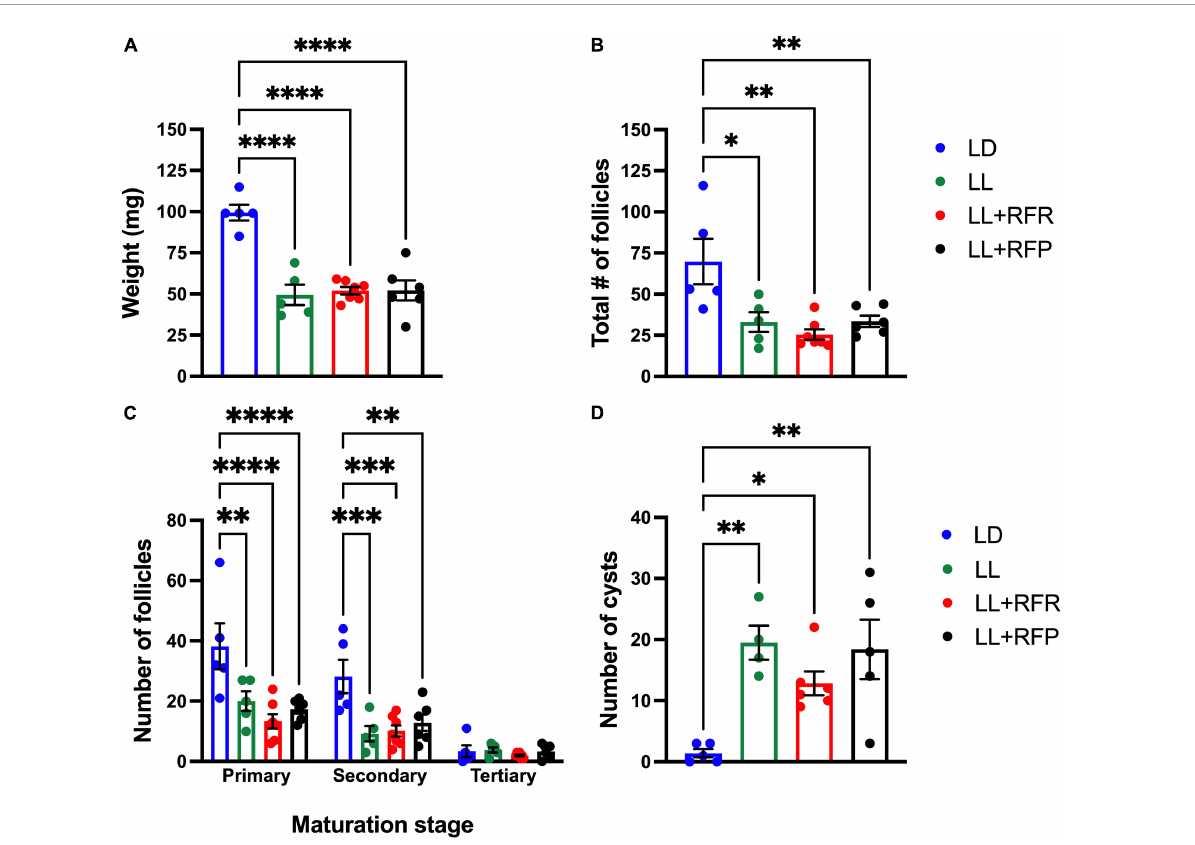
FIGURE4 Ovary weight and morphology after LL exposure and the 12-h feeding schedules. (A) Ovary weight, (B) total number of follicles, (C) number of primary, secondary, and tertiary follicles, (D) number of cysts. Rats exposed to a regular light–dark cycle (LD, blue), exposed to constant light (LL, green), or exposed for 3 weeks to LL followed by 12-h restricted feeding as a rescue strategy (LL + RFR, red) and rats exposed to LL simultaneously to RF for 6 weeks as a preventive strategy (LL + RFP, black). Data are expressed as the mean ± SEM; n = 5–7/group. Asterisks indicate ∗ P < 0.01, ∗∗ P < 0.001, ∗∗∗ P < 0.001 and ∗∗∗∗ P < 0.0001.